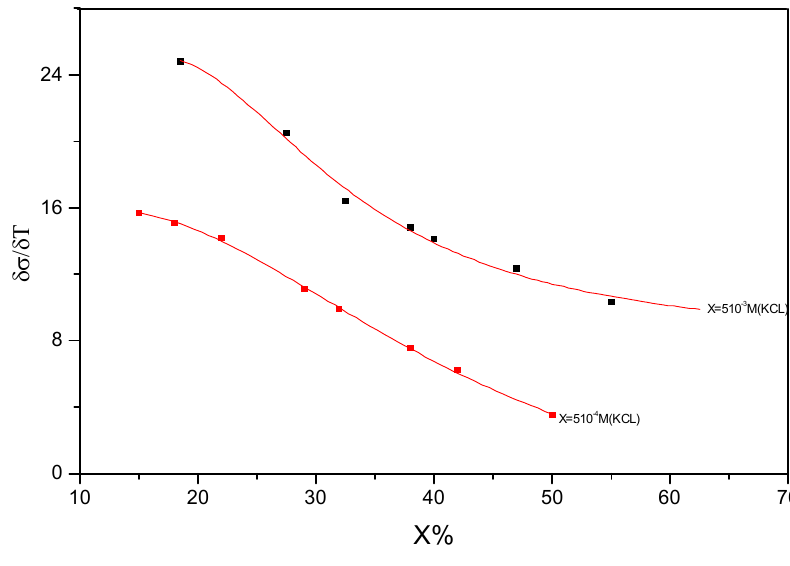
Figure 3. Thermal derivative ∂σ / ∂ T as a function of X composition in acid, showing the influence of the concentration of (K + , Cl - )